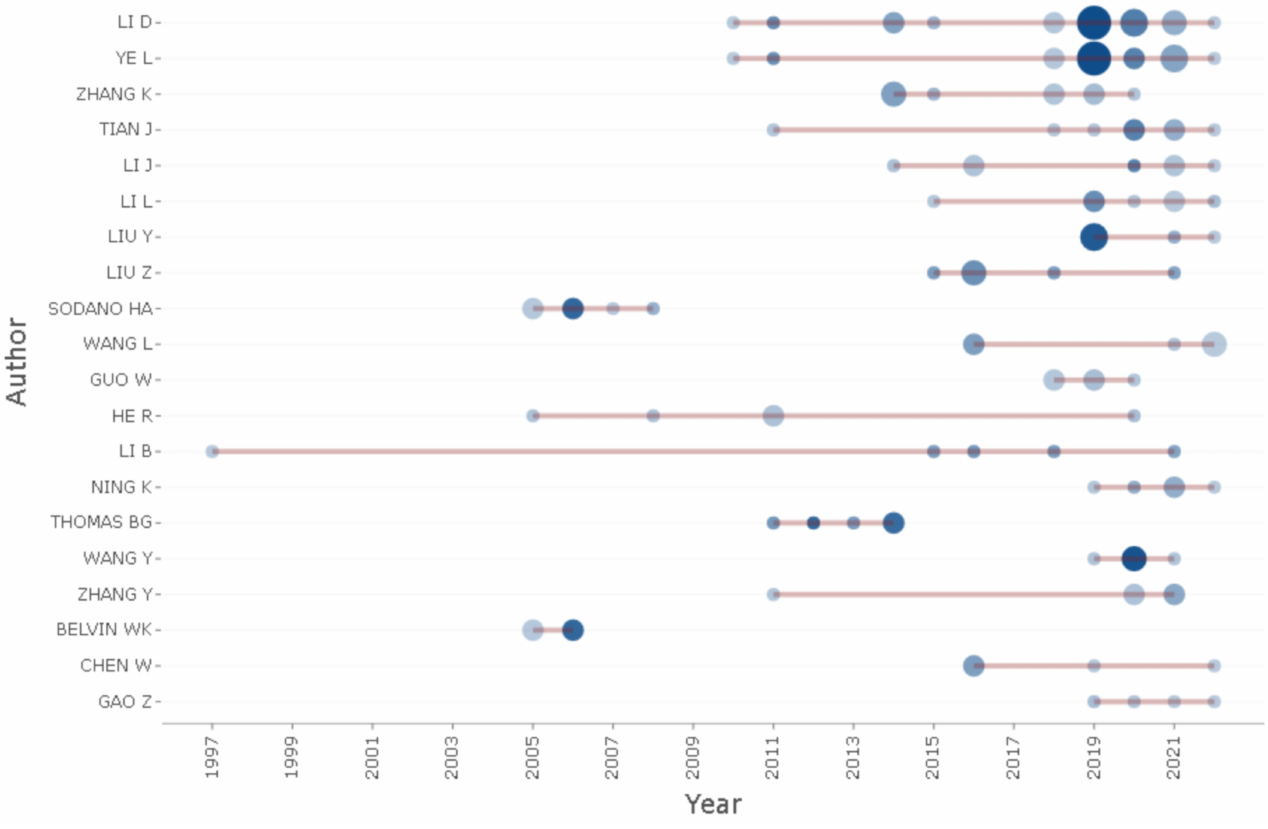
Figure 2. Top-authors’ production over